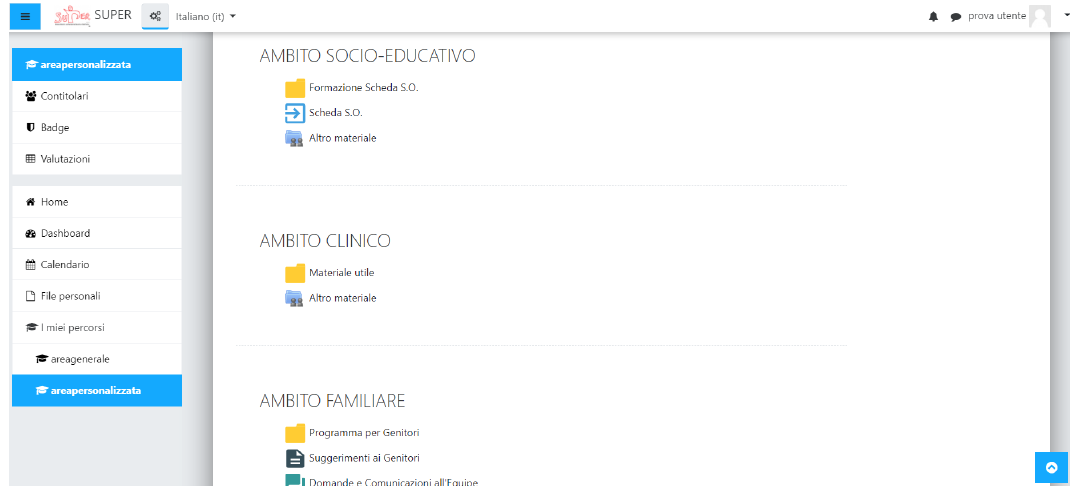
Figure 3. Screenshot of the different sections of the Personalized Area. The figure shows the three specific sections of the Personalized Area designed for each user